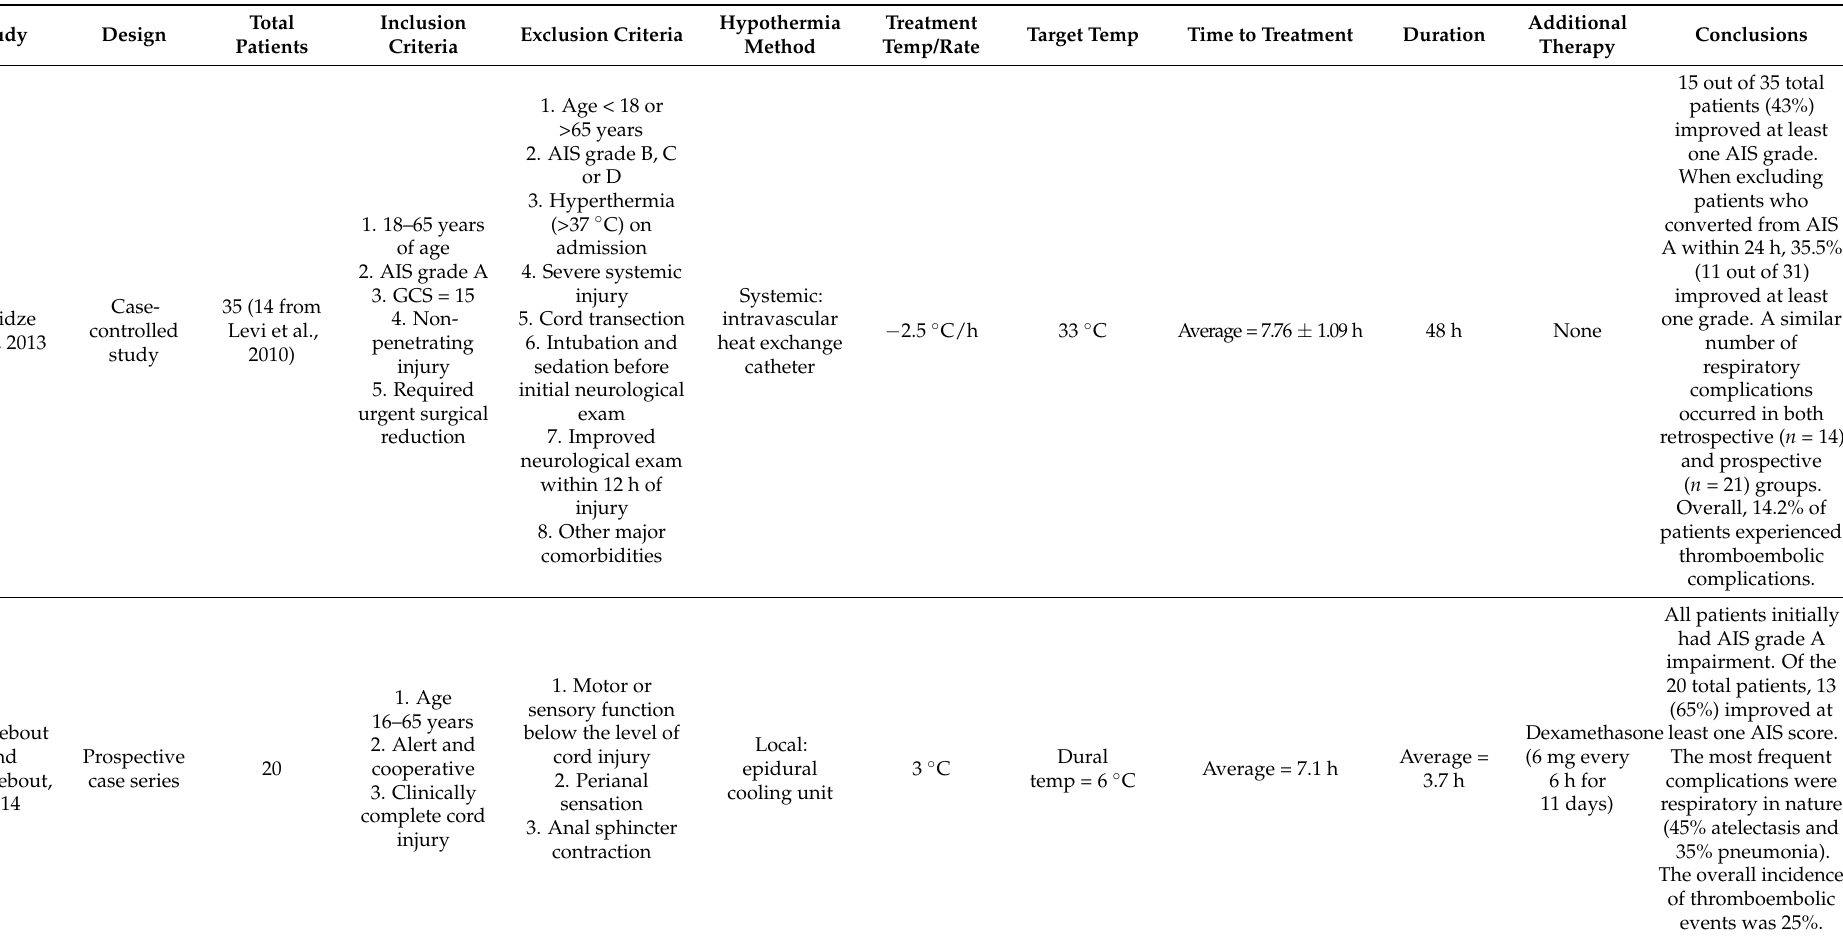
Table 2. Overview of four clinical trials using hypothermia as therapy after traumatic spinal cord injury [43–46]. AIS = ASIA (American Spinal Injury Association) Impairment Scale; GCS = Glasgow Coma